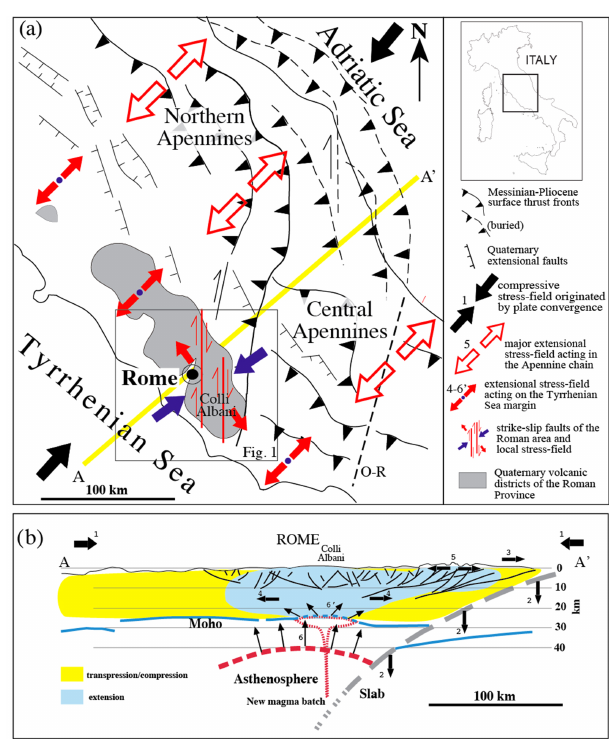
Figure 2. Structural scheme of central Italy: map (a) and cross- section (b) showing the competing tectonic force fields and the main faults associated with them that acted in the Middle–Upper Pleis- tocene. See text for comments and